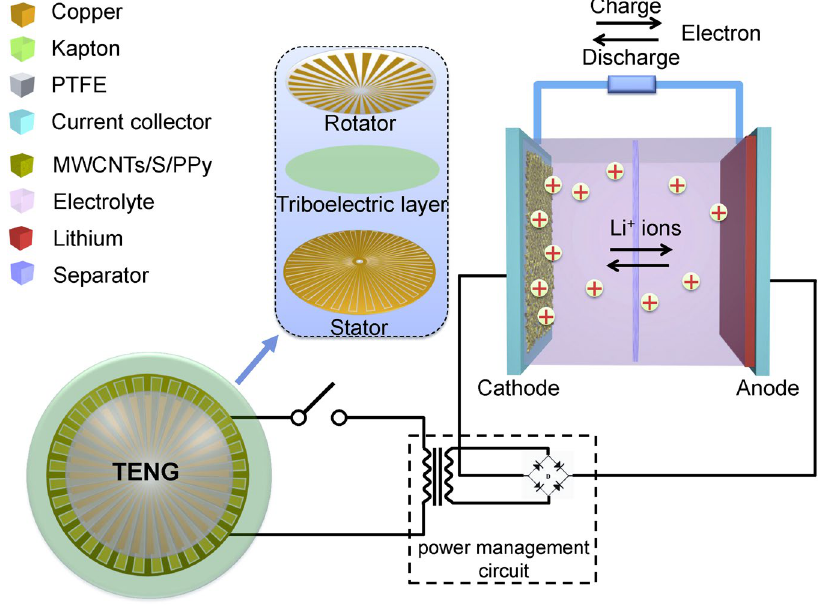
Figure 1. Schematic image of storing the pulse energy generated by the TENGs in a Li-S battery with MWCNTs/S/PPy as the